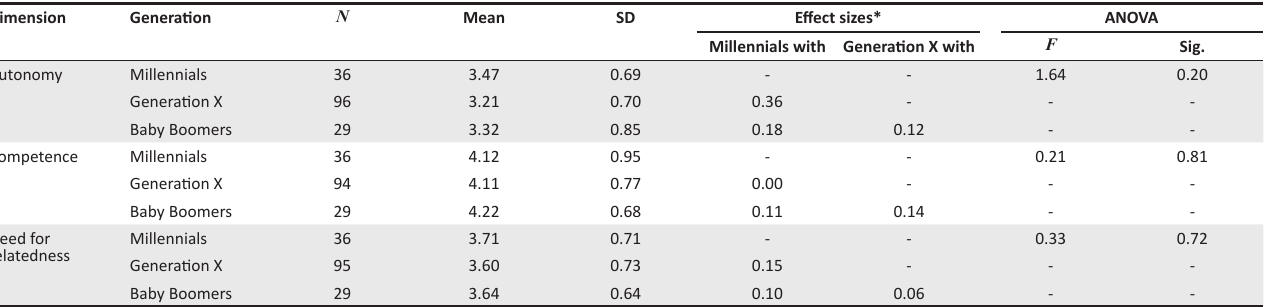
TABLE 4: Descriptive statistics and analysis of variance results for basic intrinsic motivational needs.